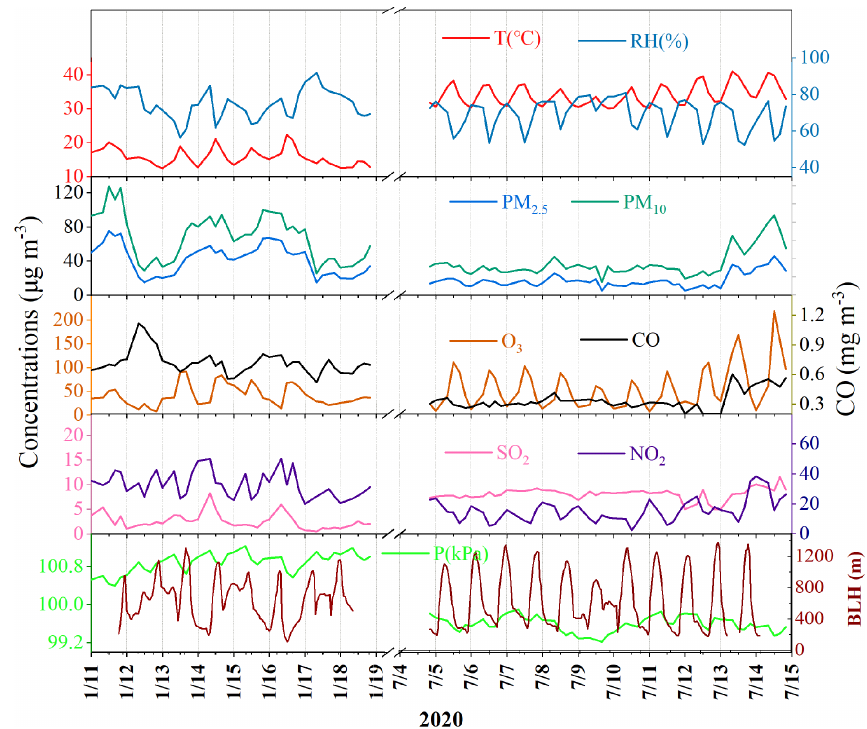
Figure 1. Time series of criteria air pollutants and meteorological parameters during the sampling